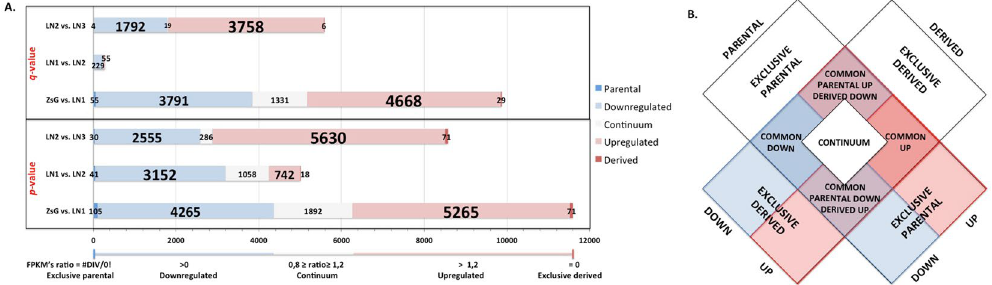
Figure 1. Regulation of the differentially expressed genes. ( A ) Exclusive, down regulated, continuum and up regulated for p- and q- values. ( B ) Clusters of gene expression after comparison of the regulated genes from parental and its derived cell lines. In white, DEGs without regulation of expression (exclusive to parental or to derived cell lines and continuum), in blue, down regulated DEGs and in red, up regulated DEGs; light purple, intersections between down regulated and up regulates